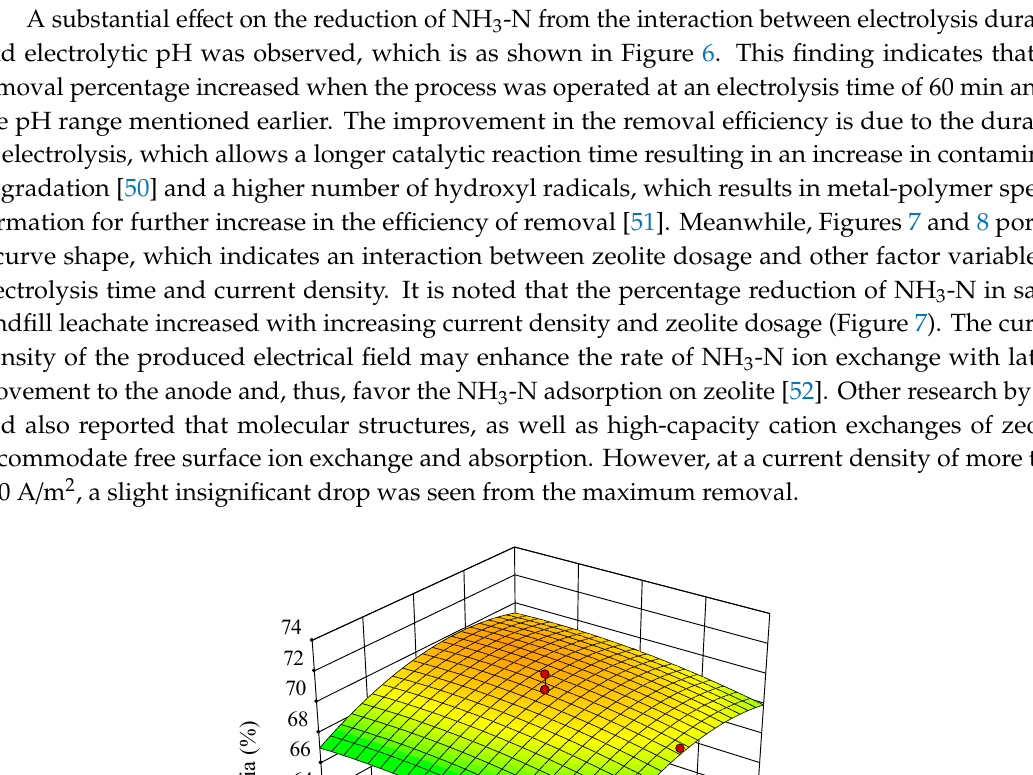
Figure 6. 3D surface plots for removal of ammonia on influences of electrolysis time and pH.